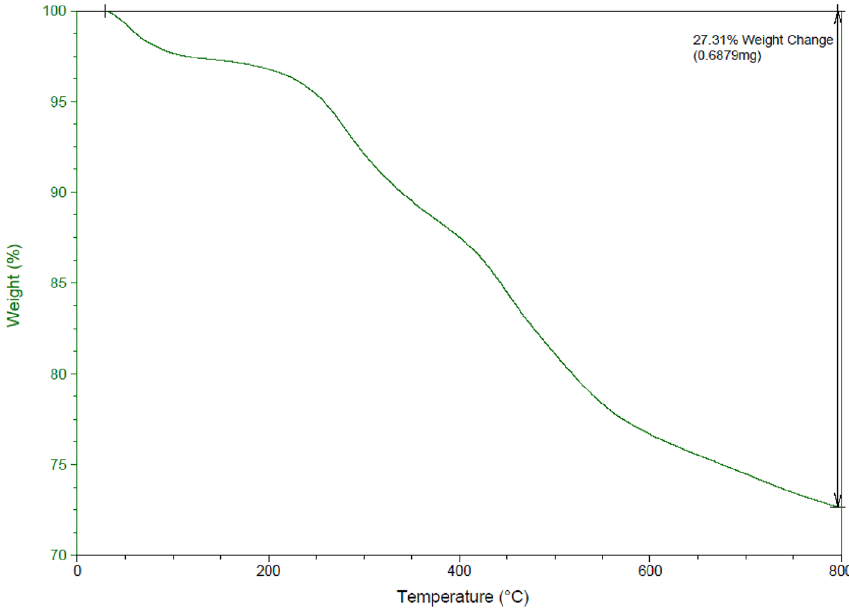
Figure 3. TGA diagram of Pip@MGO nanocomposite.